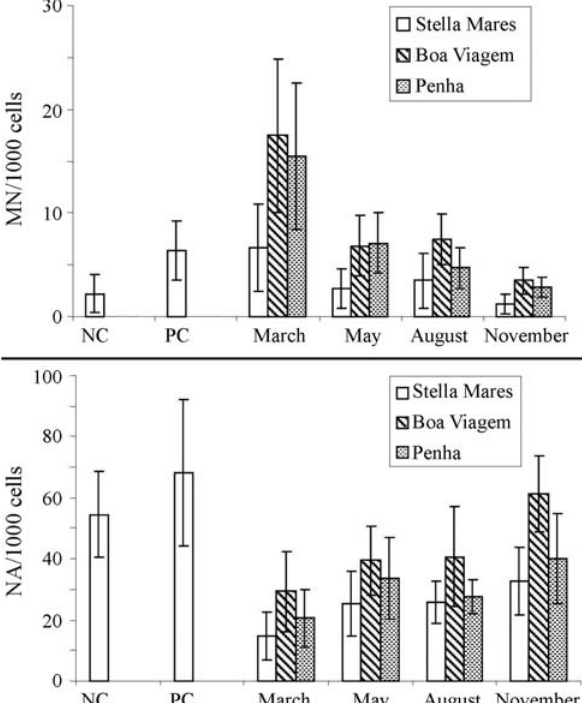
Figure 1 - Precipitation during four months of 2005 and mean frequency of micronucleated erythrocytes and nuclear abnormalities in B. soporator at three sites in and, Salvador-Bahia, Brazil. NC: negative control; NP: positivecontrol;Prec.mm/months:precipitationmm/months.MN:micro- nucleus; NA: nuclear